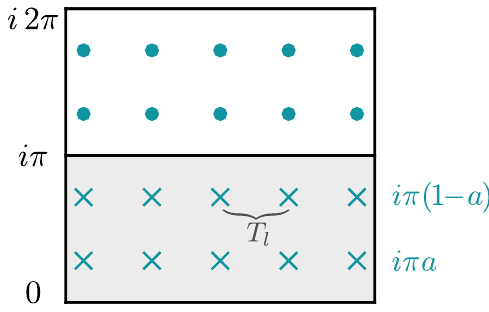
Figure 1. Analytic structure of the elliptic sinh-Gordon S -matrix in the complex rapidity plane. Simple zeros (poles) are depicted by crosses (dots). The shaded region is the physical rapidity strip 0 ≤ Im ( θ ) ≤ π which contains two crossing symmetric towers of infinite resonances separated in the real direction by the period T l